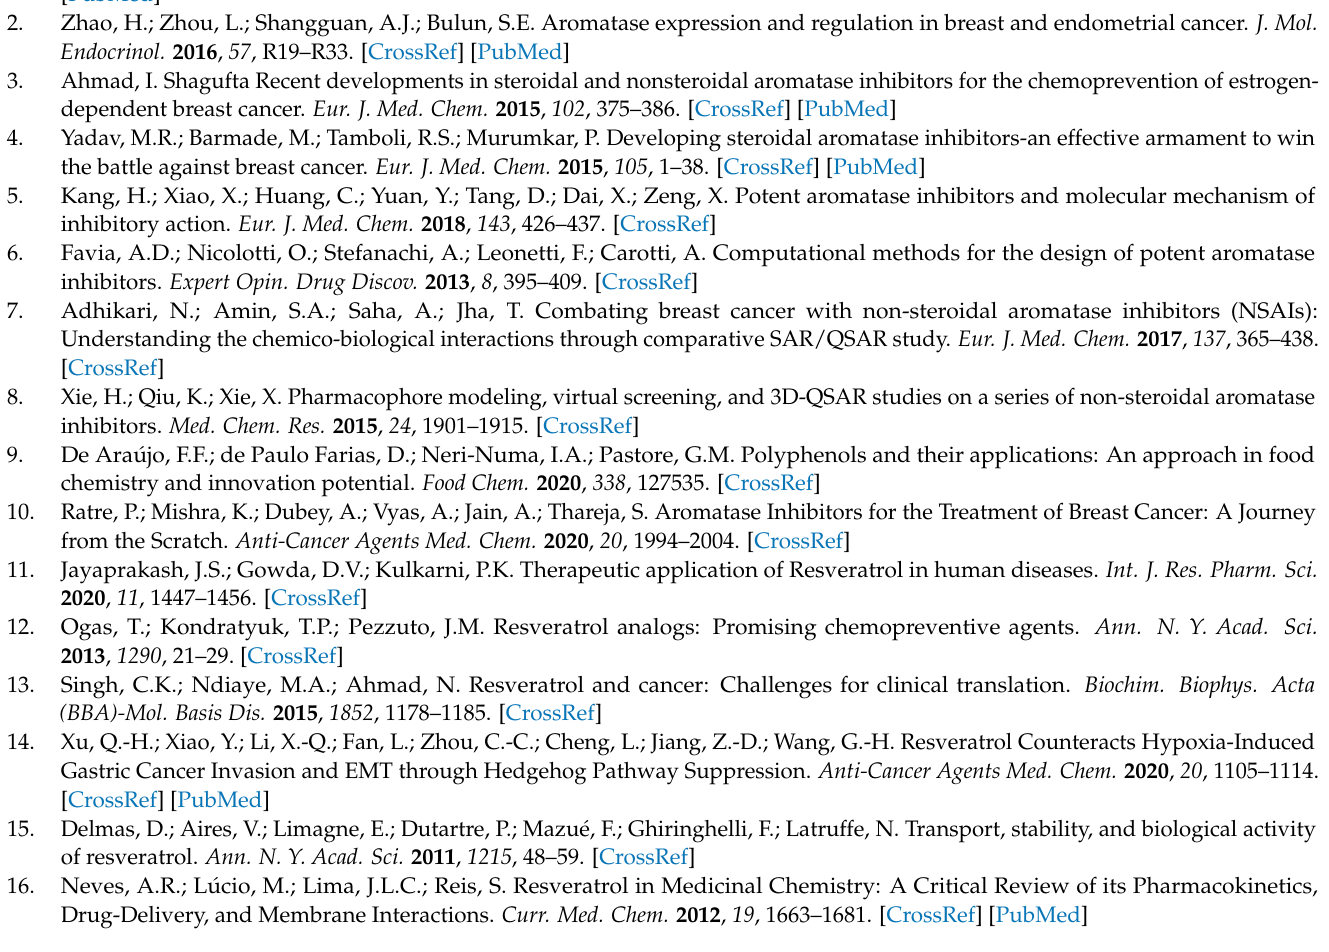
Figure S20: N-{4-[(E)-2-phenylvinyl]phenyl}ethanesulfonamide 2i ; Figure S21: 1-phenyl-N-{4-[(E)-2- phenylvinyl]phenyl}methanesulfonamide 2j ; Figure S22: 5-chloro-N-{4-[(E)-2-phenylvinyl]phenyl} thiophene-2-sulfonamide 2k ; Figure S23: Chromatograms of the active compounds 1b – c and 1j in neutral conditions; Table S1: Raw data for the IC50 calculation related to MCF7 cells in the presence of increasing concentrations of compounds 1b , 1c , 1j and Resveratrol for 24 and 72